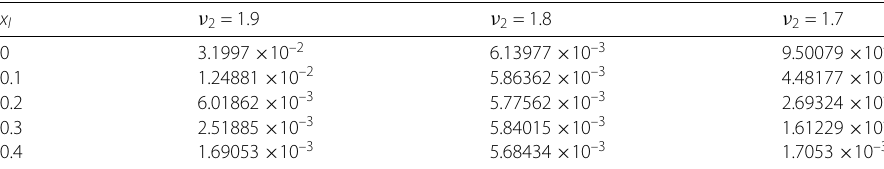
Table 3 Residual error E 8 at ν 2 = 1.9,1.8,1.7 for Example 4